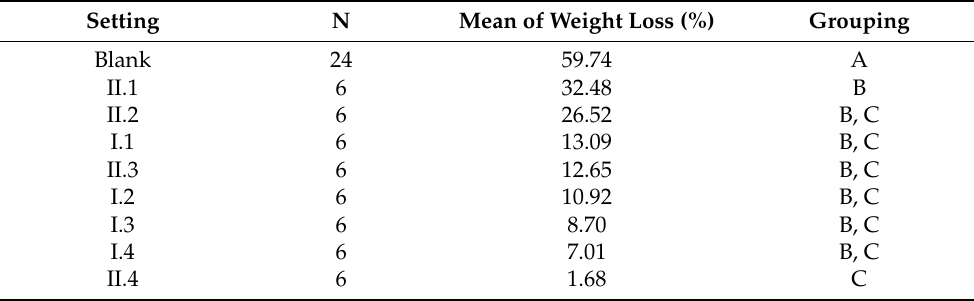
Table 5. Grouping information of samples using the Tukey method and 95% confidence.